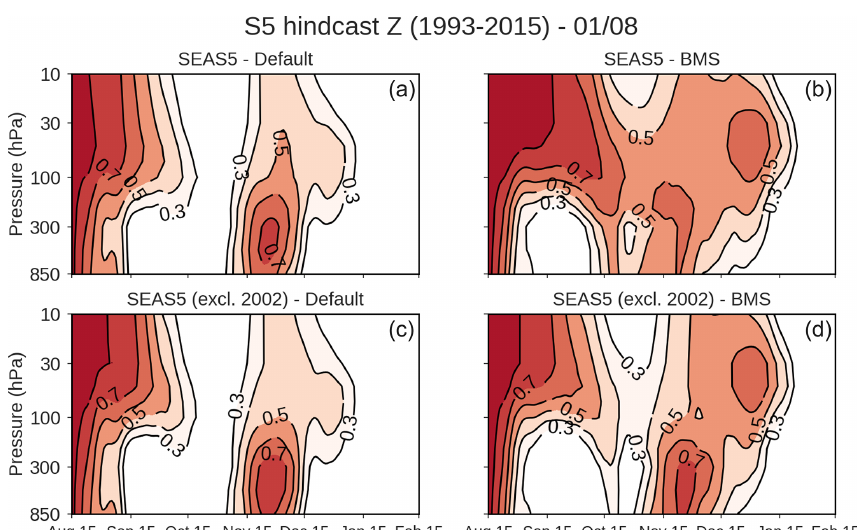
Figure 18. Correlation values between 30d mean ensemble mean SH polar-cap averaged geopotential height for the seasonal experiments and 30d mean ERA-Interim SH polar-cap averaged geopotential height, as a function of pressure level and calendar day. Seasonal exper- iments are from SEAS5 default configuration (a, c) and from SEAS5 with BMS ozone (b, d) . The period shown is 1993–2015 (a, b) and 1993–2015 excluding year 2002 (c, d) . Coloured areas indicate statistically significant correlations at the 95% confidence level. Darkest red colours indicate higher correlations; contour labels increase by